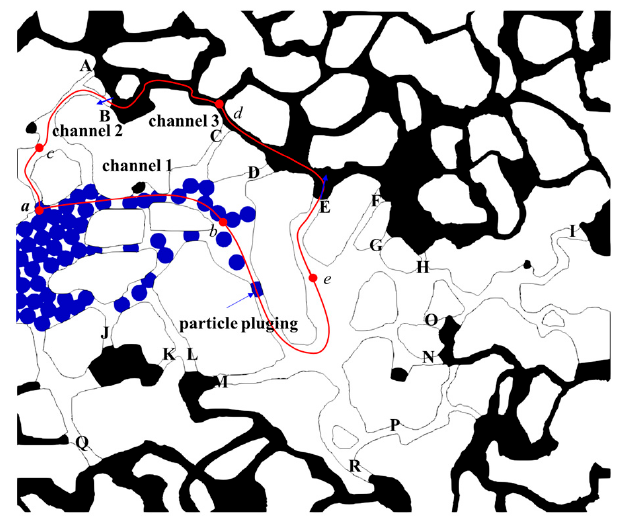
Figure 4. Distribution of particle–water–oil in the porous media at 0.26 s when remaining oil starts to move in case II (continuous